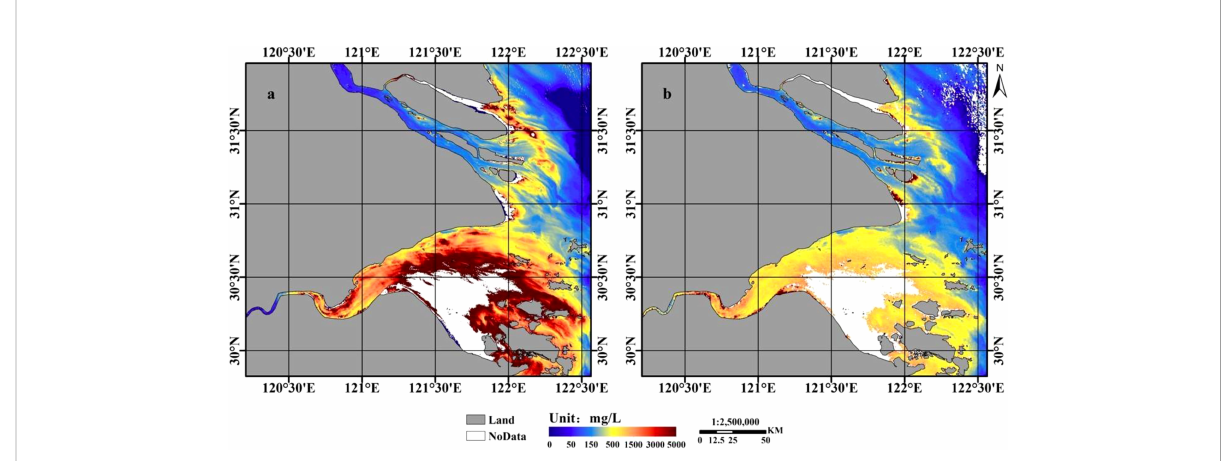
FIGURE 9 Retrieval results of SSC based on OLCI (A) and GOCI (B) data (April 13,